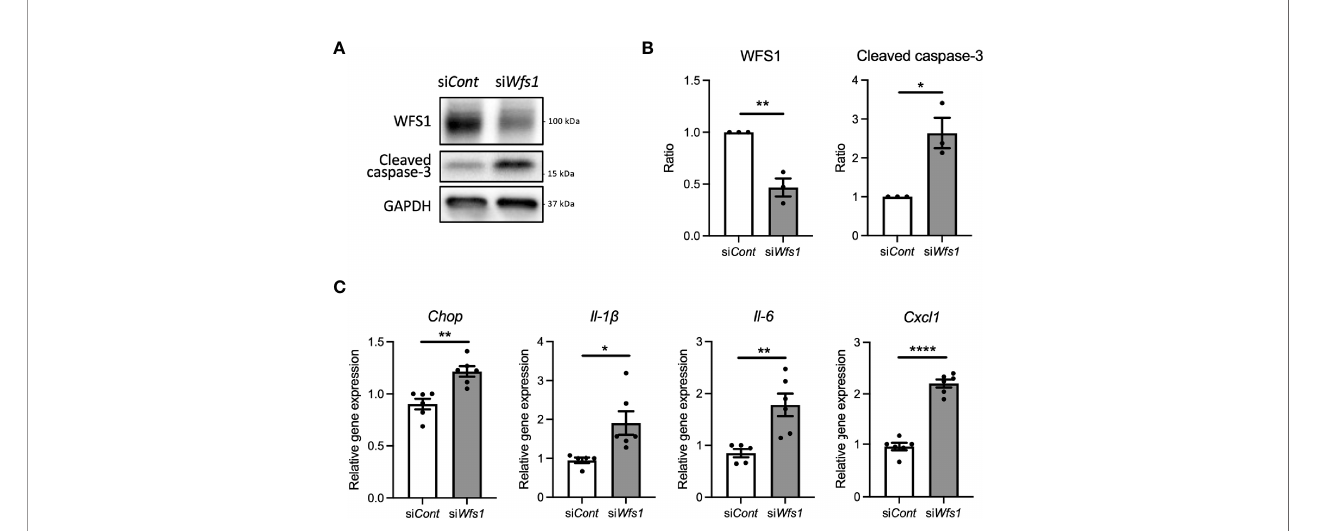
FIGURE 1 | Cell apoptosis and expression of pro-in fl ammatory cytokine genes are upregulated in Wfs1 -de fi cient pancreatic b -cells. (A, B) INS-1E cells were transfected with scrambled siRNA (si Cont ) or siRNA targeting rat Wfs1 (si Wfs1 ). WFS1 and cleaved caspase-3 protein expression levels were analyzed by immunoblot. Representative images are shown in (A) , and quantitative analysis results are shown in (B) (n=3, normalized to GAPDH). (C) mRNA expression levels of Chop , Il-1 b , Il-6 , and Cxcl1 ( Il-8 ) in INS-1E cells treated with si Cont or si Wfs1 normalized to 18srRNA (n=5-6). Data are shown as mean ± SEM, *P < 0.05, **P < 0.005, ****P <